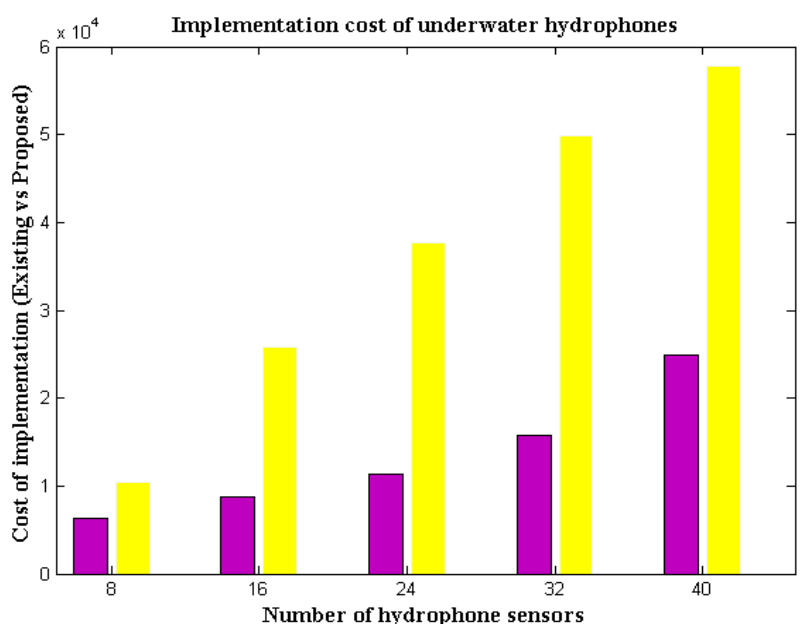
Figure 7. Prototype implementation cost.